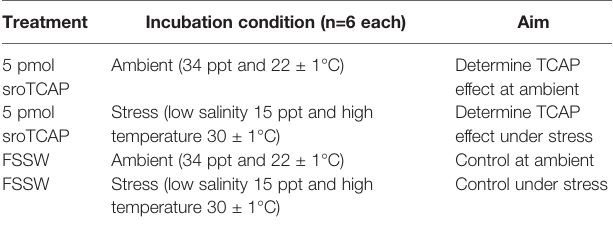
TABLE 1 | Summary of injection and incubation conditions used for hemocyte transcriptome analysis.